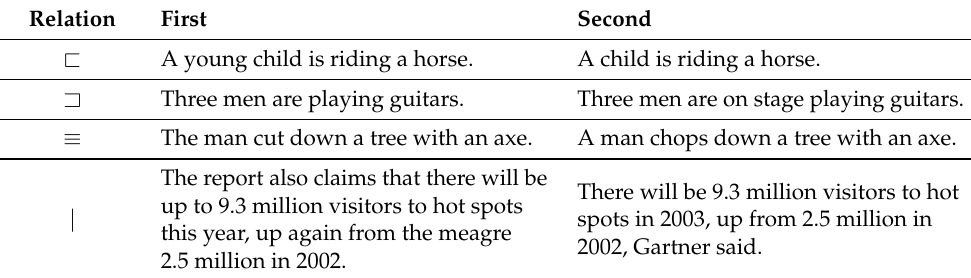
Table 3. Fine-grained paraphrase